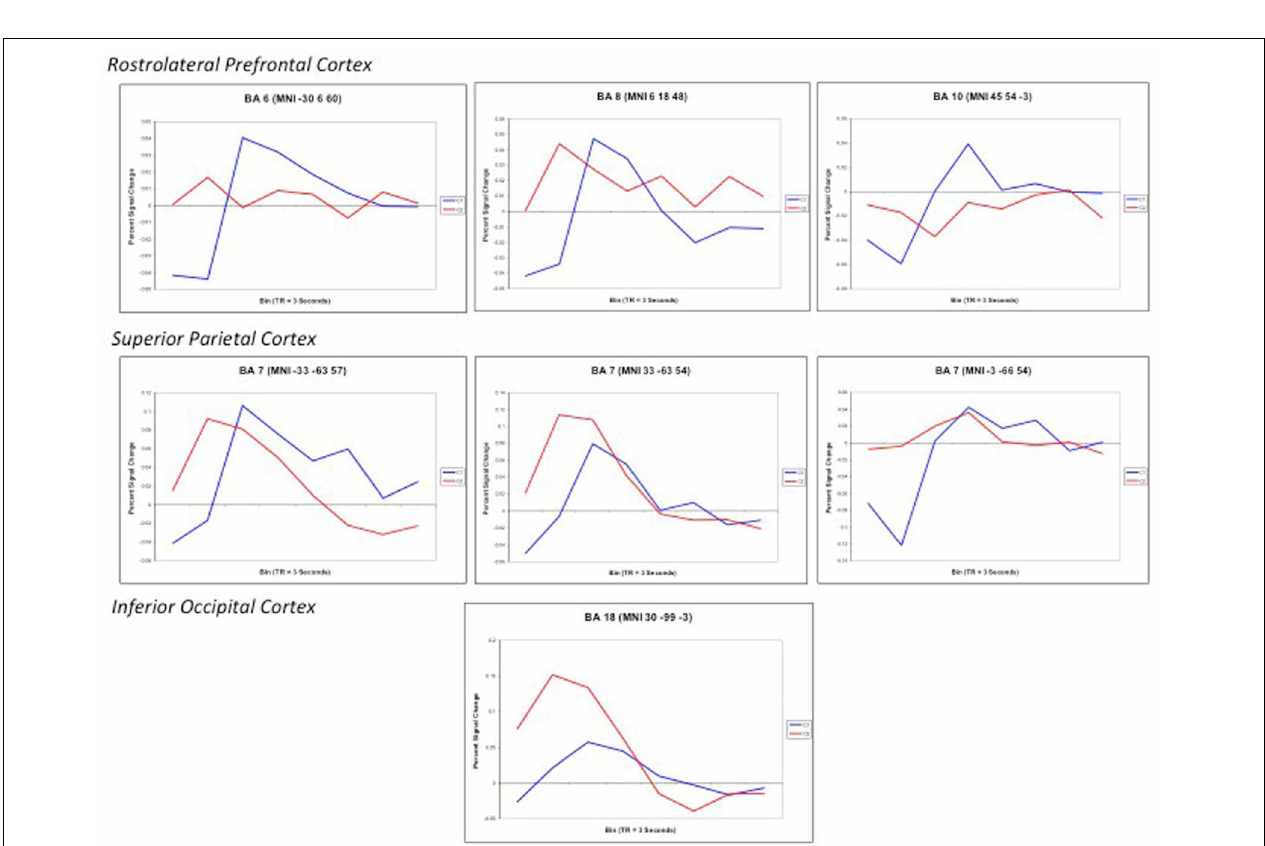
(B) Percent signal change in Brodmann 6 across levels of complexity, (C) Percent signal change in Brodmann 8 across levels of complexity, (D) Percent signal change in Brodmann 10 across levels of complexity.